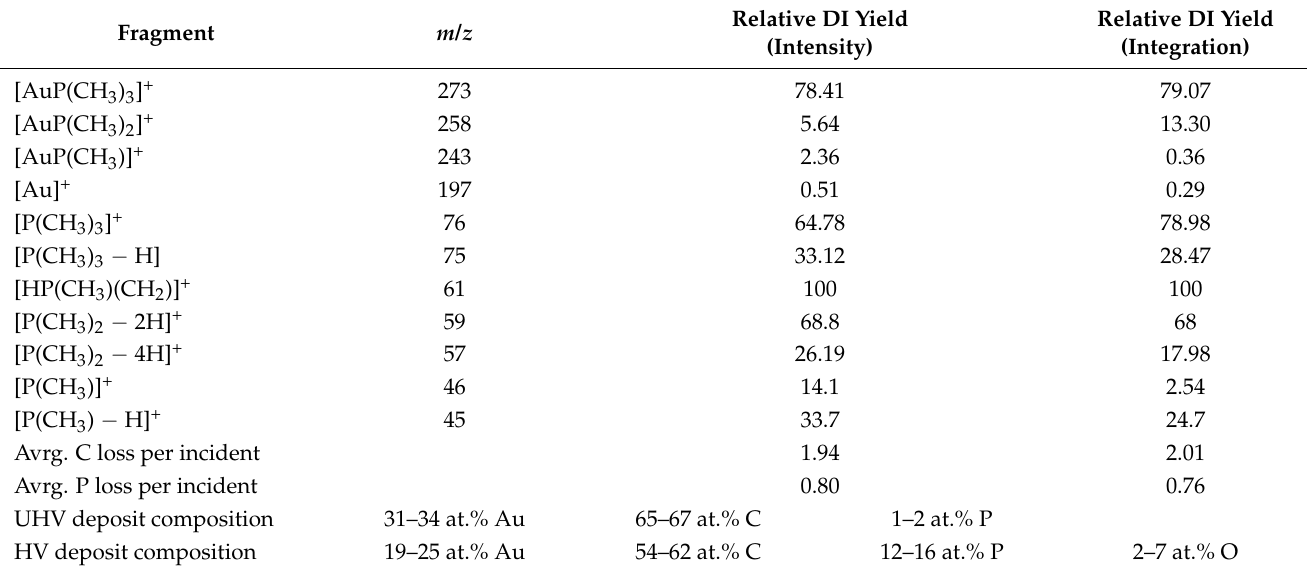
Table 2. Relative peak intensities of (CH 3 )AuP(CH 3 ) 3 fragments at 50 eV electron impact energy observed in the DI mass spectrum (Figure 3) and relative integral intensities from thresholds to 50 eV derived from the ion yield curves shown in Figure 5. The FEBID deposits compositions from the current UHV and the previous HV experiments are shown at the bottom of the